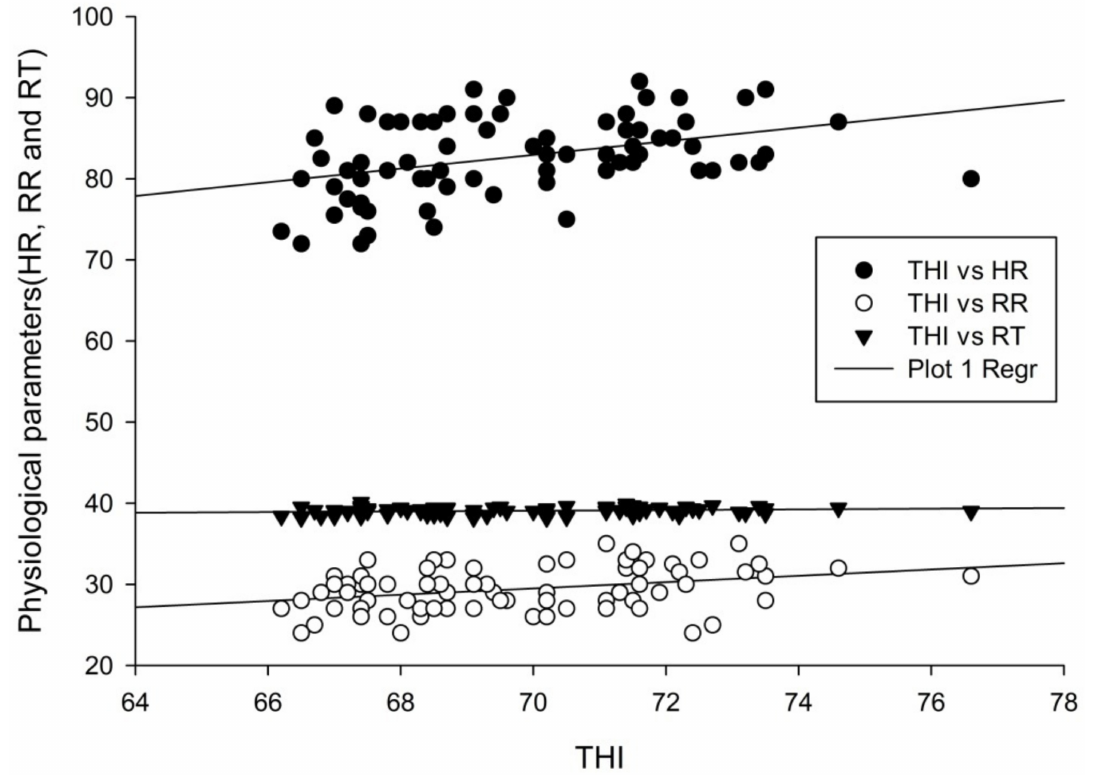
Figure 2. Relationship between the temperature–humidity index and physiological parameters of calves.THI, HR, RR, and RT ( ◦ C) are temperature–humidity index, heart rate (beats per minute), respiration rate (breaths per minute), and rectal temperature in degree centigrade,